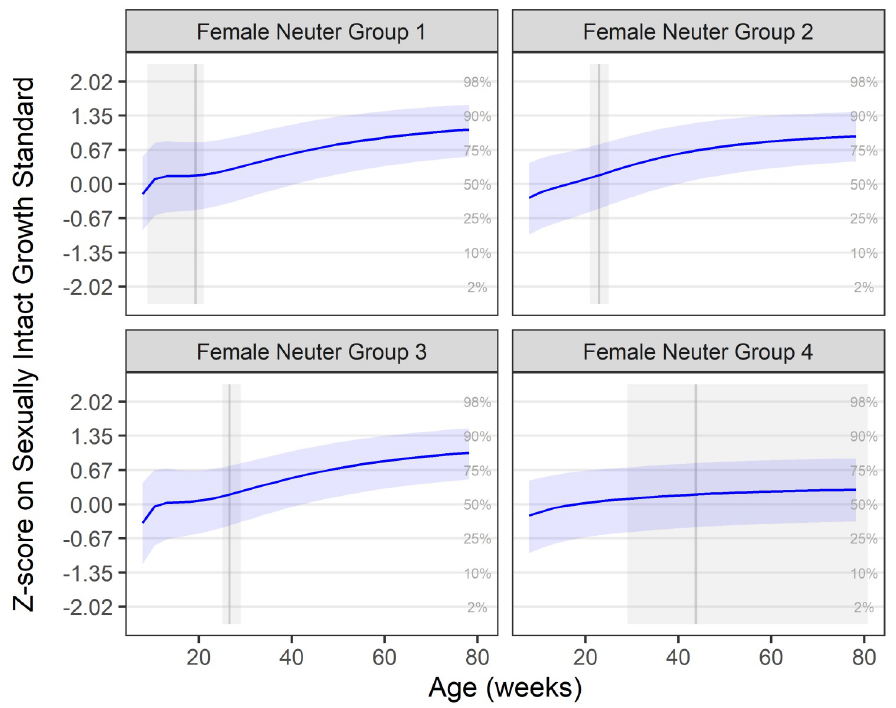
Fig 2. Median female growth trajectory by neuter group on z-score scale. Neuter Groups 1–4 represent, respectively, neutering ages of up to 21 weeks (1.0k cats), 21–25 weeks (2.7k cats), 25–29 weeks (3.0k cats) and > 29 weeks (3.8k cats). Groups were calculated from the lower quartile, median and upper quartile of ages at all ovariohysterectomy procedures performed on DSH cats between April 1994 and November 2016. The solid blue line represents the mean trajectory, whilst the blue-shaded ribbon represents the interquartile range. The grey shaded area represents the neutering age range for the group, and the solid grey vertical line shows the median observed neutering age. Grid lines represent the standard growth centiles, such that a growth trajectory following the centile curves would be horizonal in these plots. In all groups, there was an upwards inclination in growth trajectory, which was marked in neuter groups 1–3, but only modest in neuter group